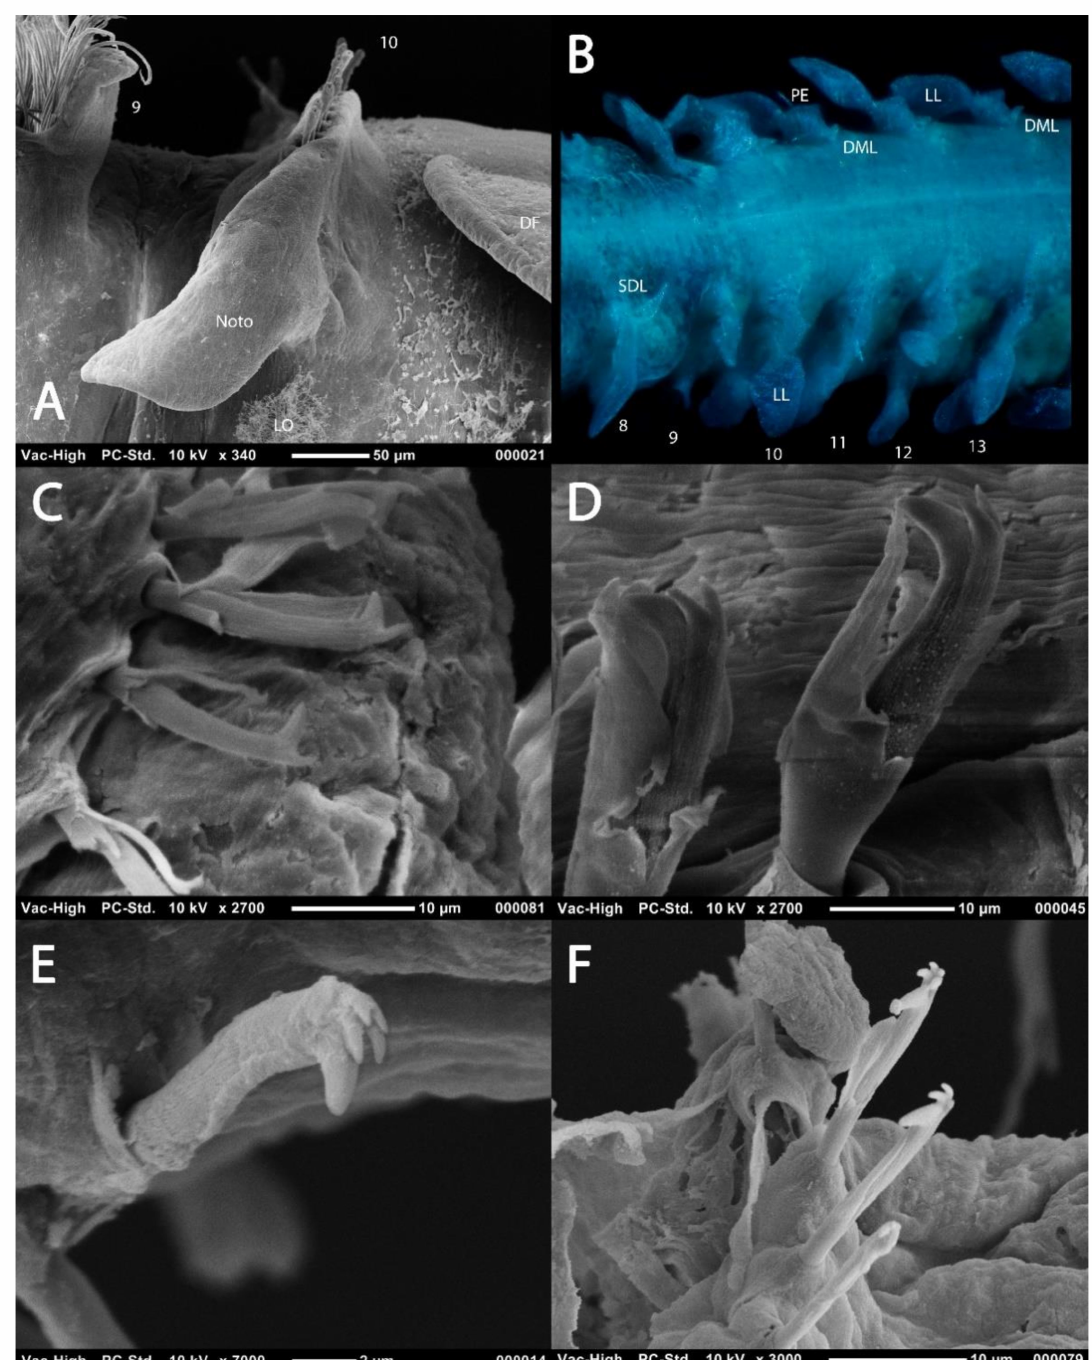
Figure 6. Abdominal parapodia and chaetae: ( A ) notopodia of chaetiger 10 of Magelona johnstoni showing abdominal hooded hoods in a vis- à -vis orientation (lateral view); ( B ), chaetigers 8–13 of M. crenulifrons (dorsal view, stained with methyl green); ( C ) bidentate abdominal hooded hook of M. minuta (lateral view); ( D ) tridentate abdominal hooded hook of M. alleni (lateral view); ( E ) pentadentate abdominal hooded hook of M. fauchaldi (oblique lateral view); ( F ) quadridentate and pentadentate abdominal hooded hooks of M. fauchaldi (oblique lateral view). ( C – F ), hoods broken via sonication prior to SEM. Abbreviations: DF—dorsal flap of the lateral pouch, DML—dorsal medial lobe, LL—lateral lamella, Noto—notopodia, PE—postchaetal expansion, SDL—superior dorsal lobe, VML—ventral medial lobe. Numbers indicate chaetiger. Figure F sourced from